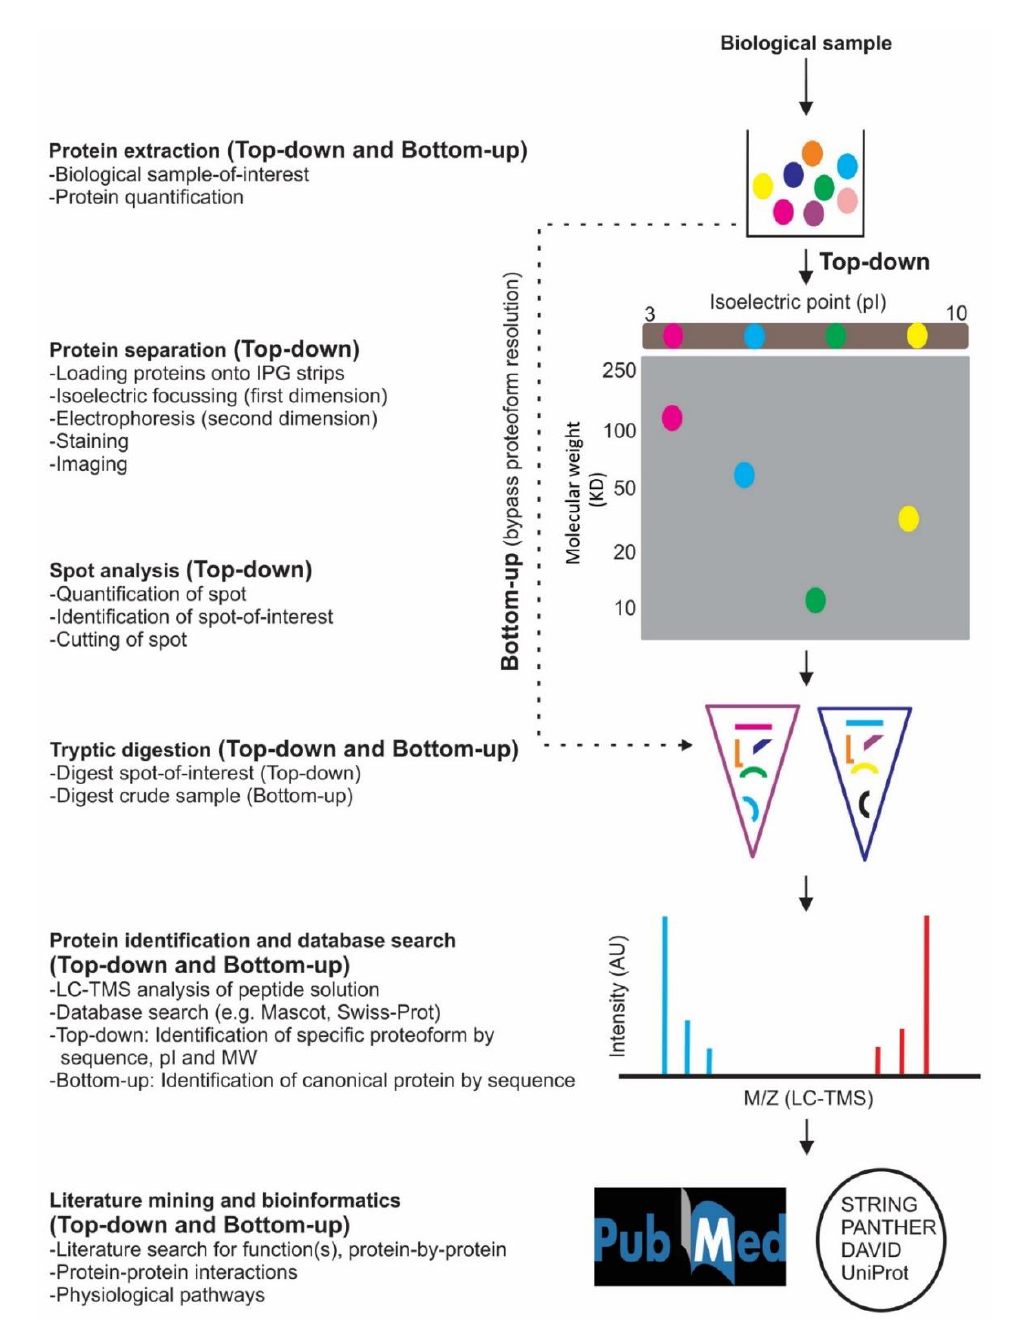
Figure 1. Schematic of top-down and bottom-up proteomic approaches. In top-down, proteoforms are extracted (sometimes then separated into total soluble and membrane fractions [104]) and resolved based on charge (i.e., pI) using immobilized pH gradient (IPG) strips, and then by size (i.e., ~MW) using SDS-PAGE gels. Spots of interest are excised from the gel, digested using proteases, and analysed by liquid chromatography-tandem mass spectrometry (LC-TMS). In contrast, bottom-up or shotgun approaches use crude digestion of the total proteoform extract, without prior resolution of intact proteoforms, and this peptide digest is then analysed by LC-TMS. In both approaches, database searches (e.g., Mascot, Swiss-Prot) then identify amino acid sequence matches; literature mining (PubMed) and bioinformatic analyses (e.g., STRING, DAVID, UniProt) are then used to assess potential functions, physiological pathways, and interactions. Image processing software CorelDraw-version 2018 (www.coreldraw.com, Ottawa, ON, Canada) was used to construct Figure.